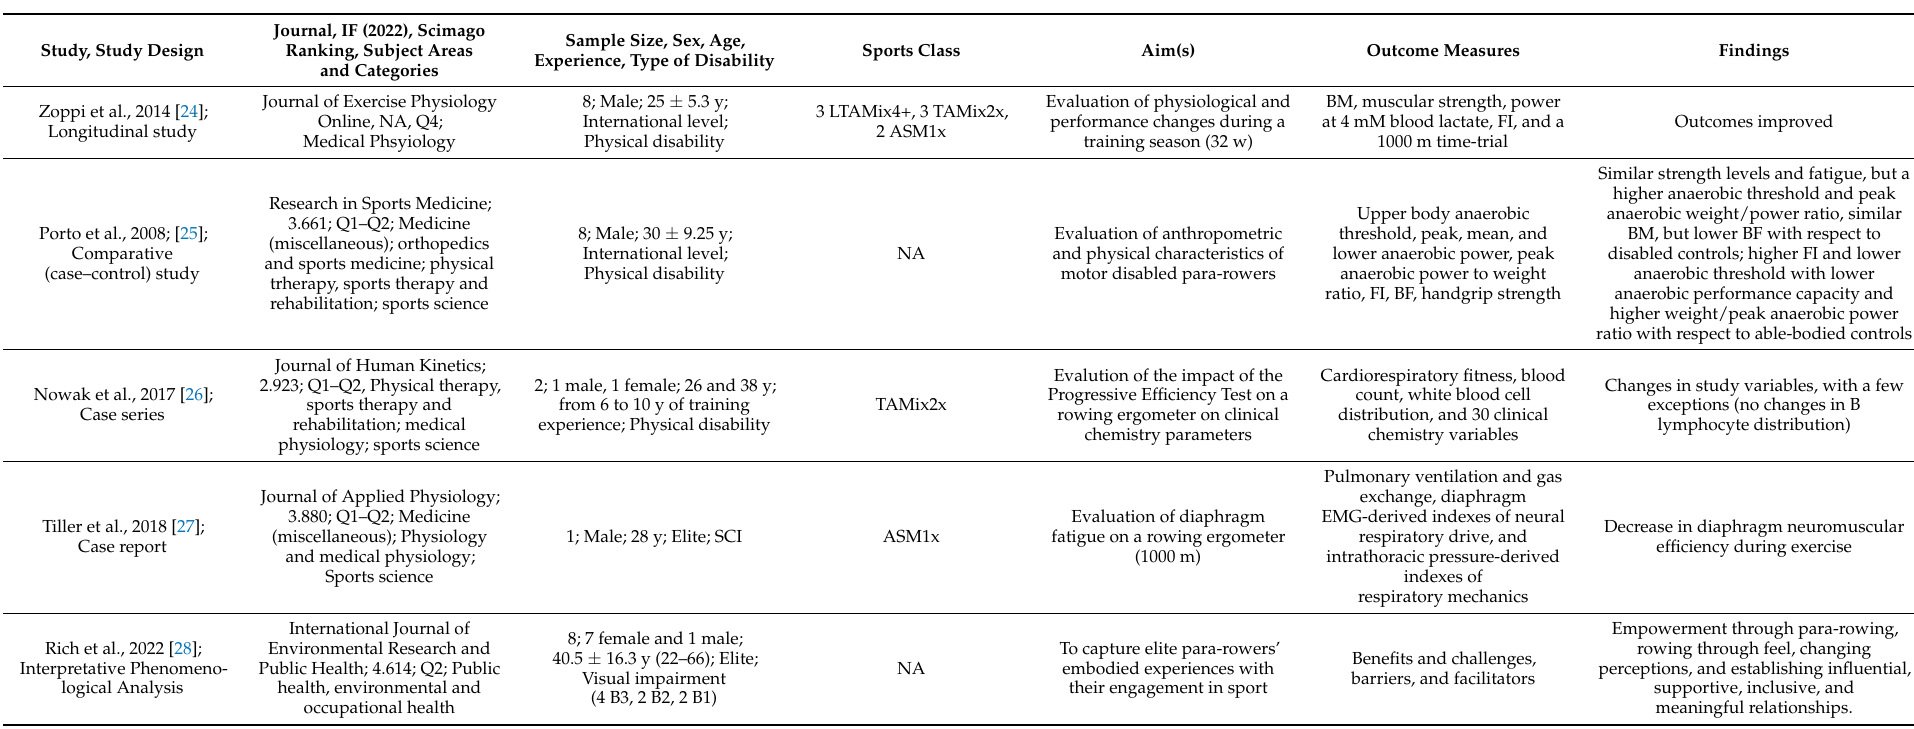
Table 1. Main characteristics of the study included in the present scoping review concerning psychological and physiological responses in para-rowing.